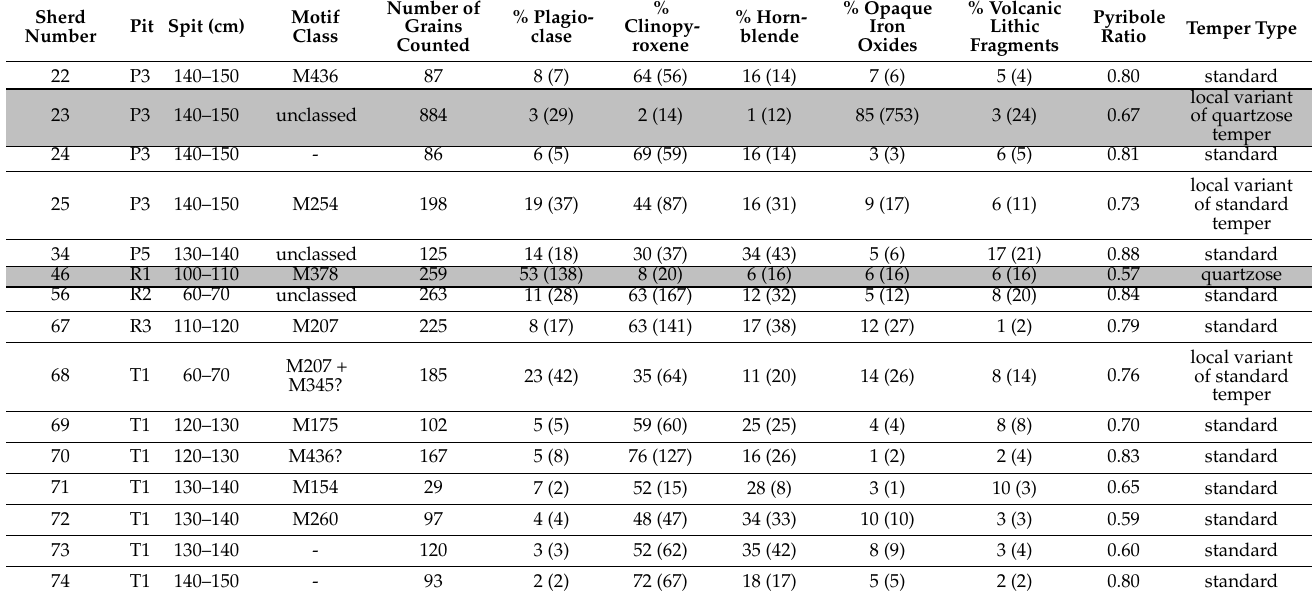
Table 1. Mineralogical analyses of sand tempers in 15 Lapita potsherds from Naitabale by Roselyn Kumar reported in this study. Mineral percentages and raw counts (in brackets) are given. Motifs classified according to the system of Anson